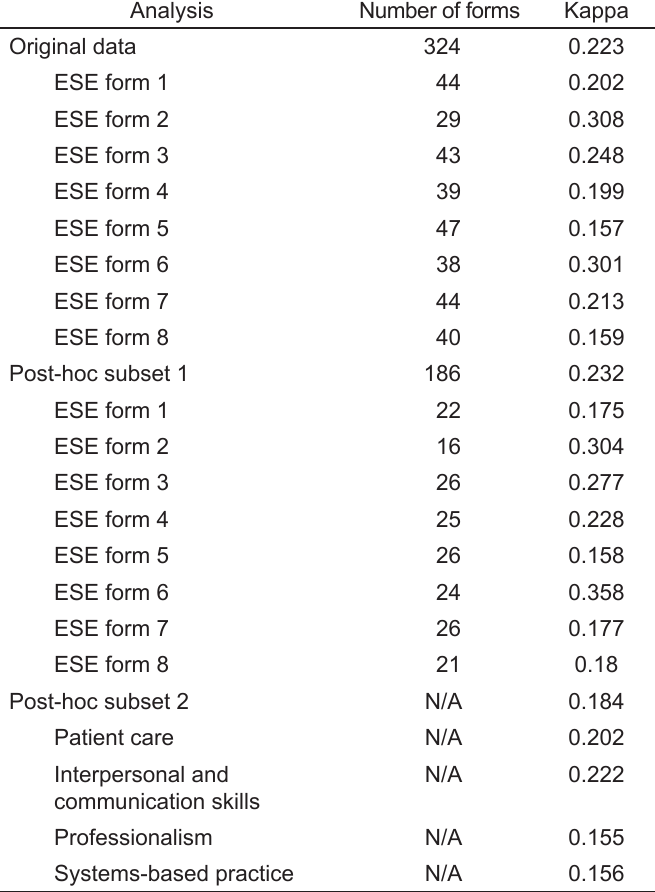
Table. Kappa for each analysis of end-of-shift evaluation